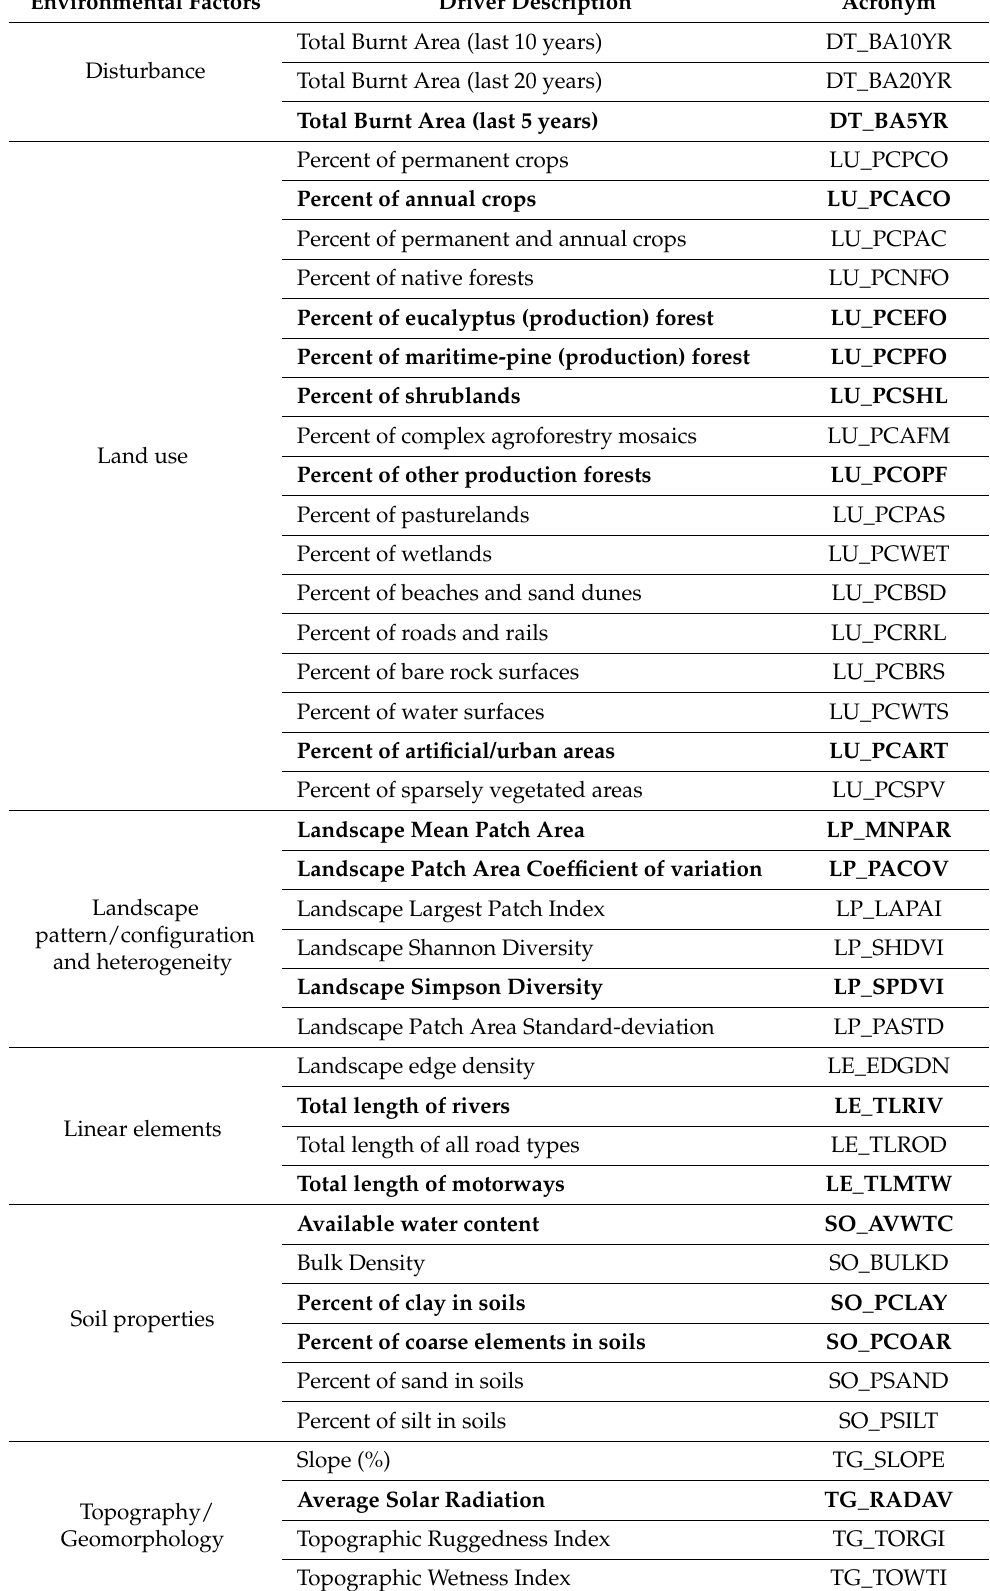
Table 2. Cont. Environmental